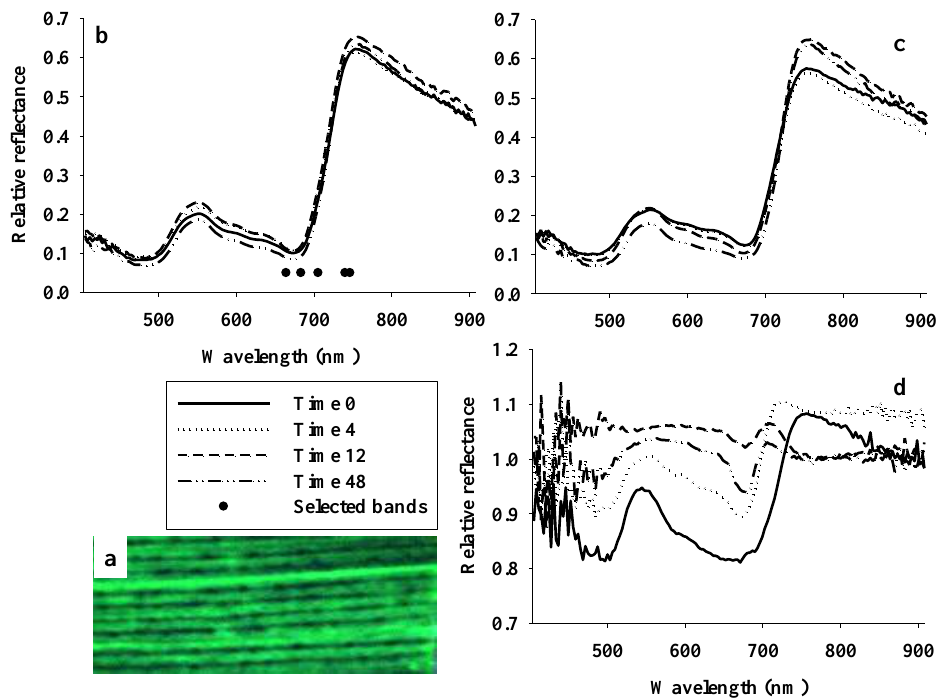
Figure 4. Average hyperspectral profiles acquired from untreated and miticide-treated maize leaves over